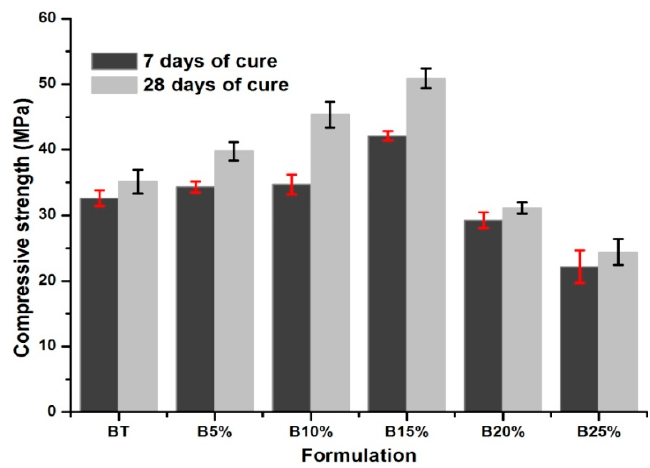
Figure 3. Compressive strength of mixtures at 7 and 28 days.